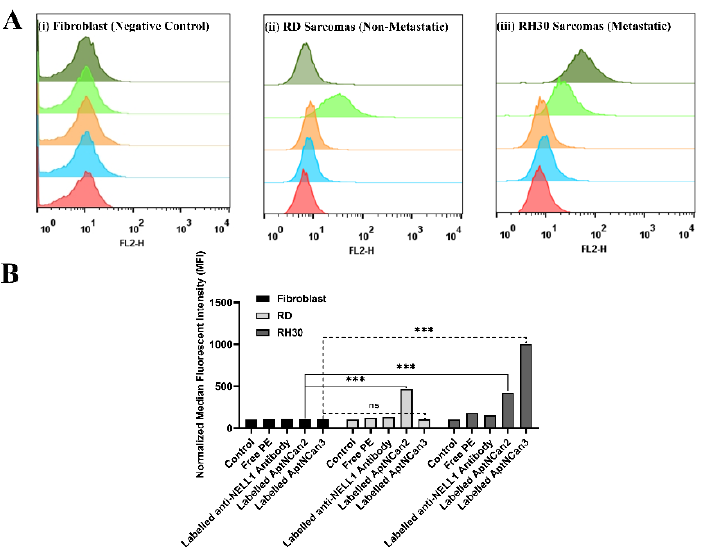
Figure 6. Validation of anti-NELL1 aptamer-specific binding measured by flow cytometry. ( A ) Representative flow cytometry histogram results for fibroblast, RD, and RH30 sarcoma cells. Cells were incubated with either PBS (red), free PE staining (blue), CF555-labeled anti-NELL1 antibody only (orange), PE-labeled AptNCan2 (light green), and PE-labeled AptNCan3 (dark green). ( B ) Results from the normalized median fluorescence intensity of flow cytometry results for fibroblast, RD, and RH30 sarcoma cells. Cells were incubated with different incubation in the PBS (control), free PE staining, CF555-labeled anti-NELL1 antibody, and PE-labeled anti-NELL1 aptamer 1 and 2. Data are presented as mean ±SD for each individual cell line ( n = 3 independent experiments of triplicates). Error bars were too small to be shown. Significance was tested using a two-tailed t -test compared to the untreated cells for each cell line (*** p ≤ 0.005 and ns = not significant).